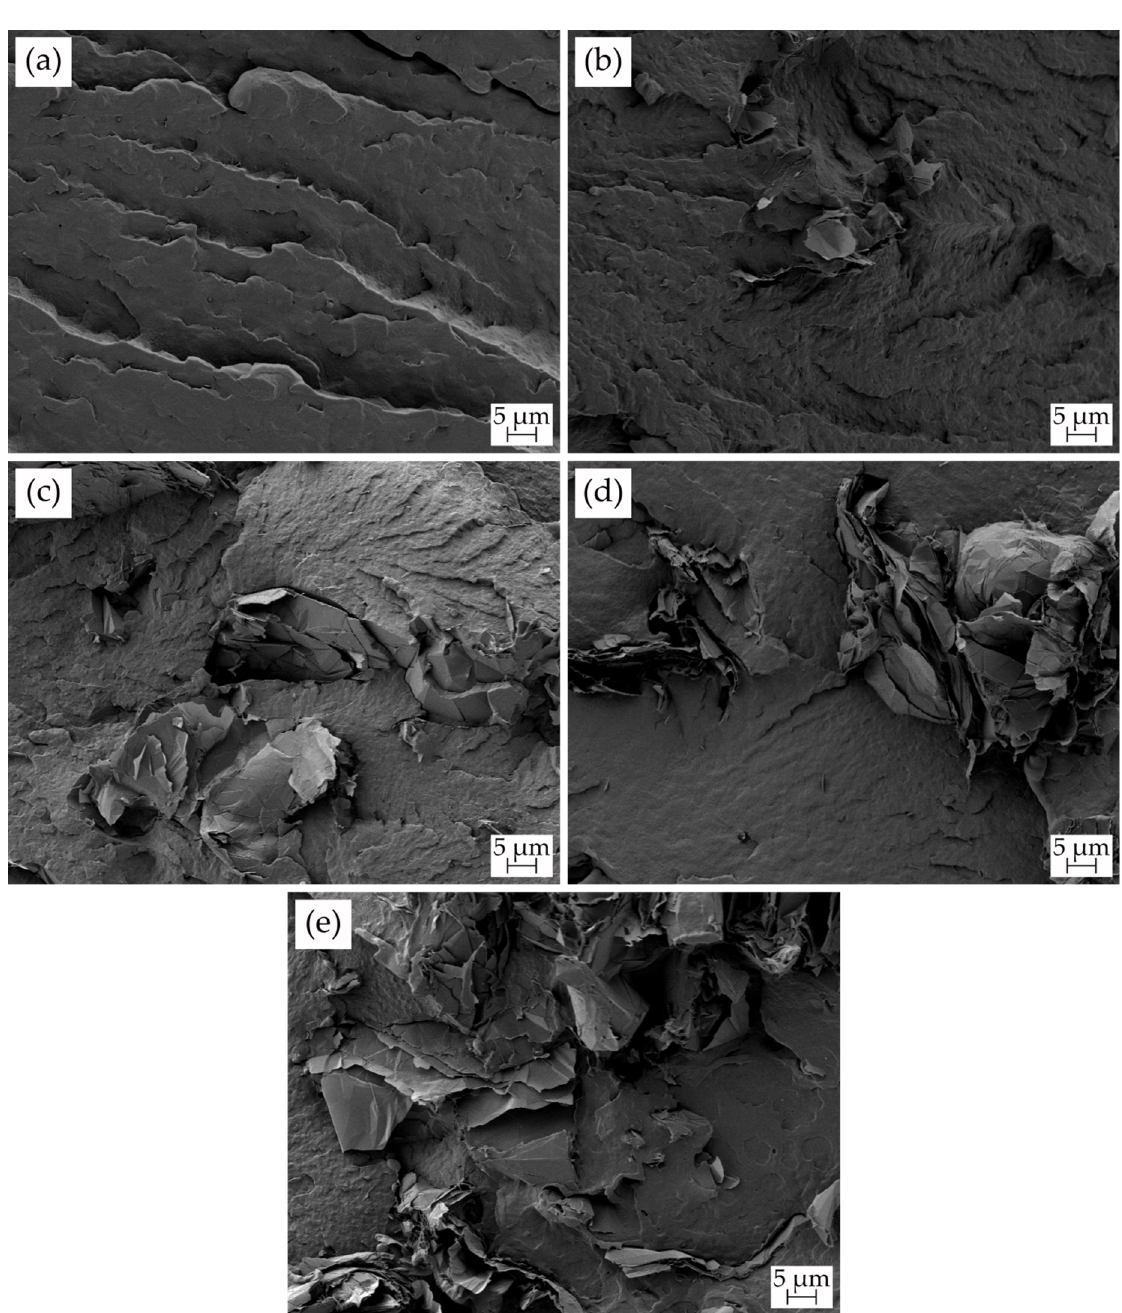
Figure 2. Field emission scanning electron microscopy (FESEM) images at 1000× of the fracture sur- faces of the PA1001/EGr composites: ( a ) PA1010; ( b ) PA1010/2.5EGr; ( c ) PA1010/5EGr; ( d ) PA1010/7.5EGr; ( e ) PA1010/10EGr.